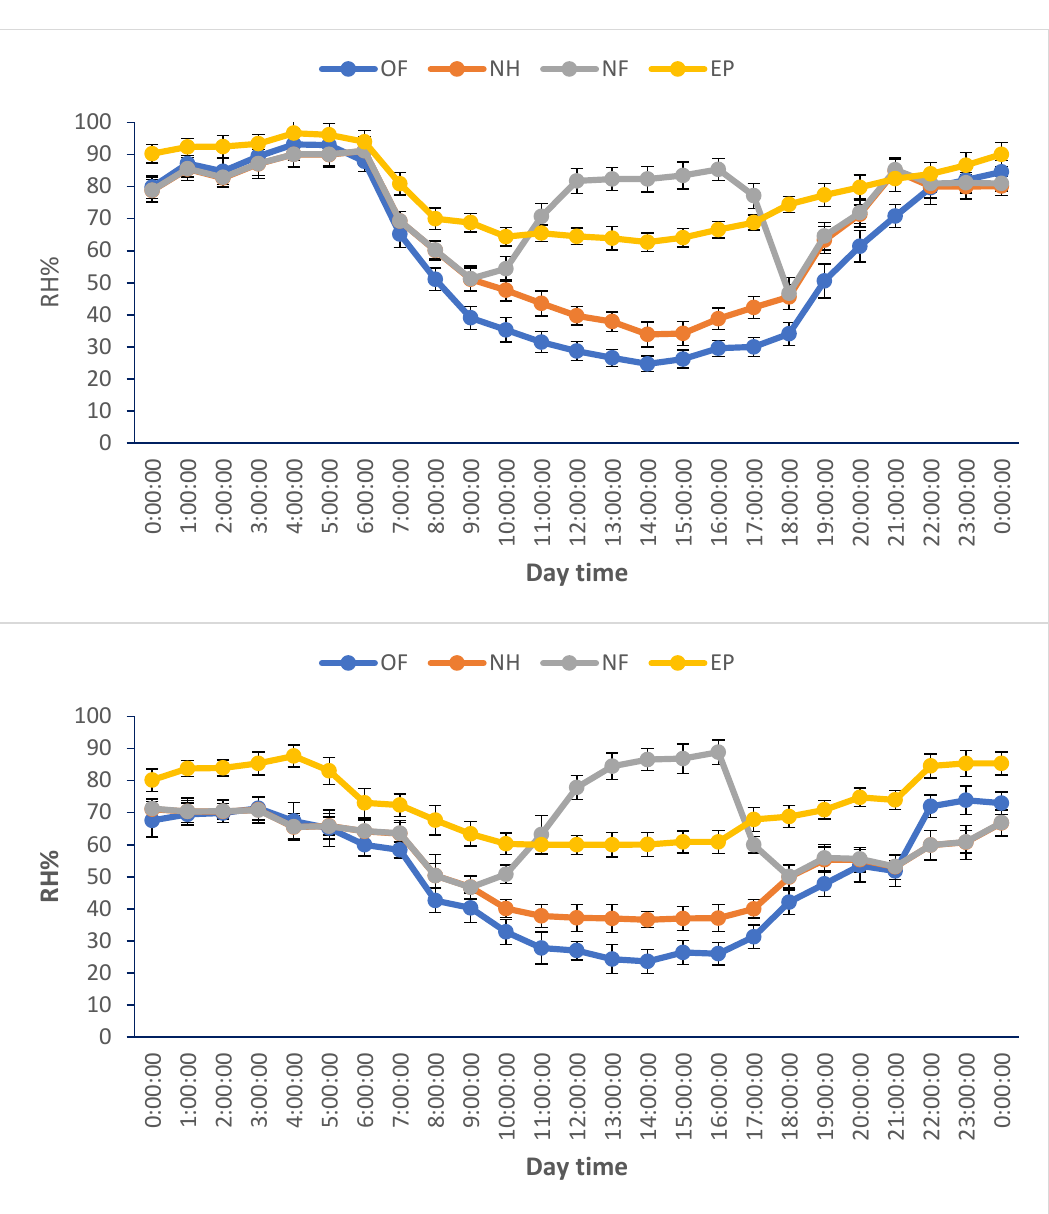
Figure 3. Hourly RH% changes during the peak of flowering and fruit set on 3 August 2020 ( upper figure) and 5 August 2021 ( lower figure ) registered in the open field (OF), net house (NH), net house with fogging (NF, operating 6 S/36 S from 10 a.m. to 4 p.m.) and evaporative cooling under plastic house (EP). Standard error of the means was derived from three biological